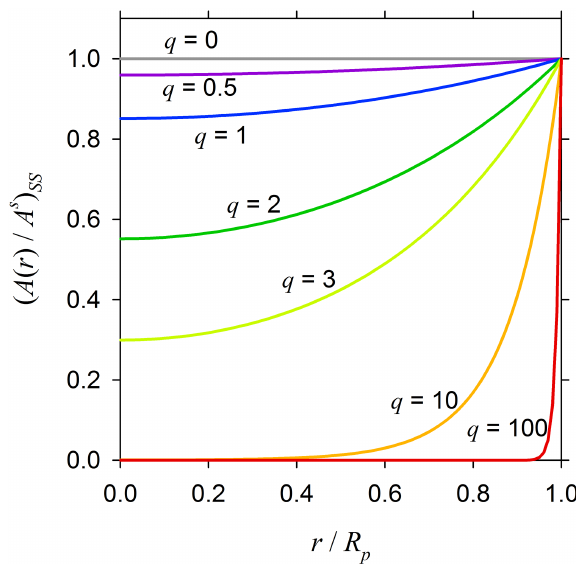
Figure 4. Normalized (A(r)/A s ) SS profiles as a function of r/R p for different values of the dimensionless diffuso-reactive parameter q